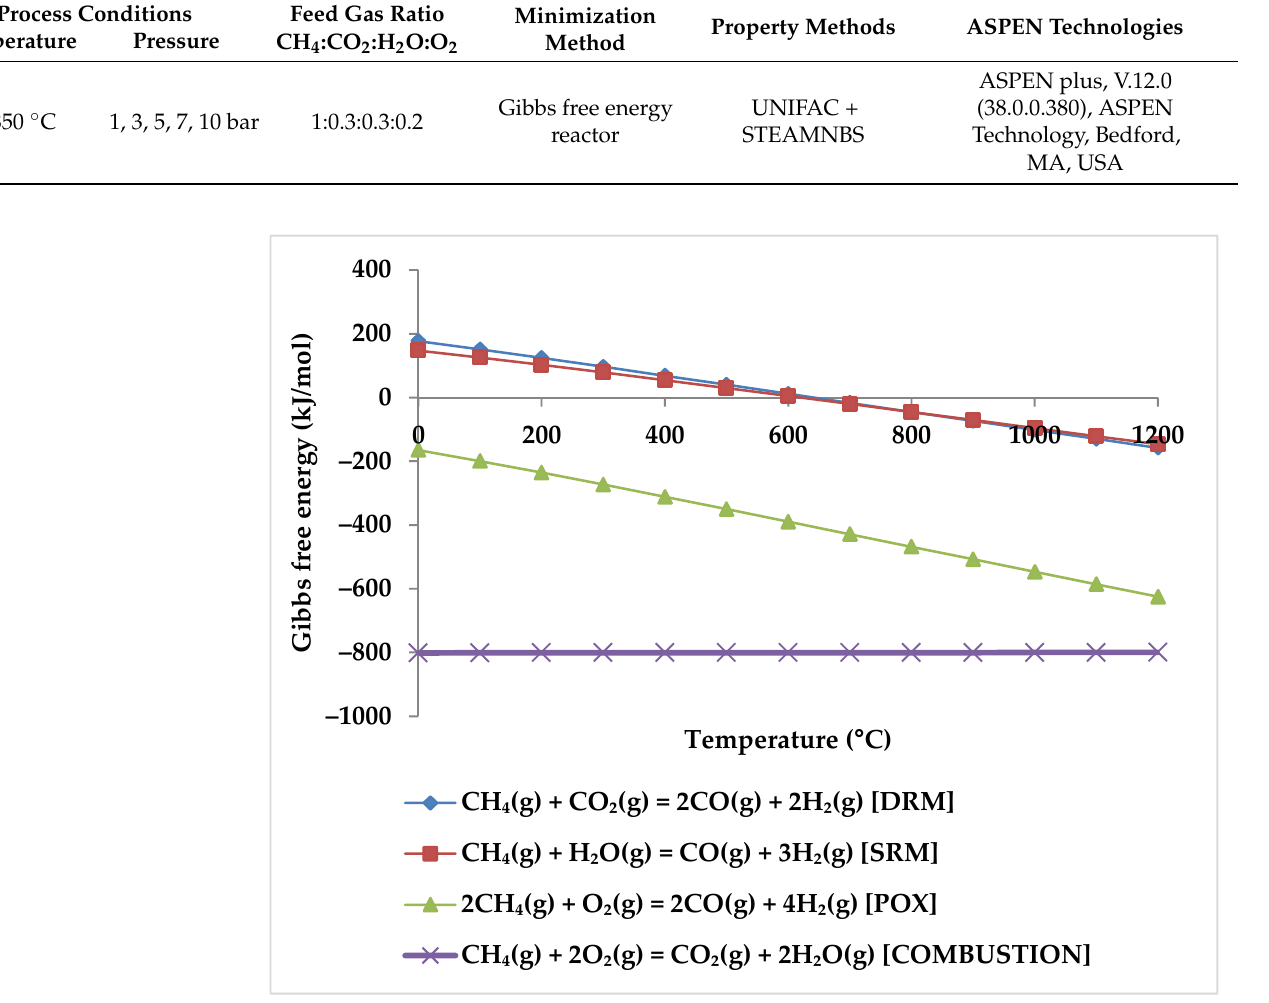
4 and H 2 O, CO 2 , and O 2